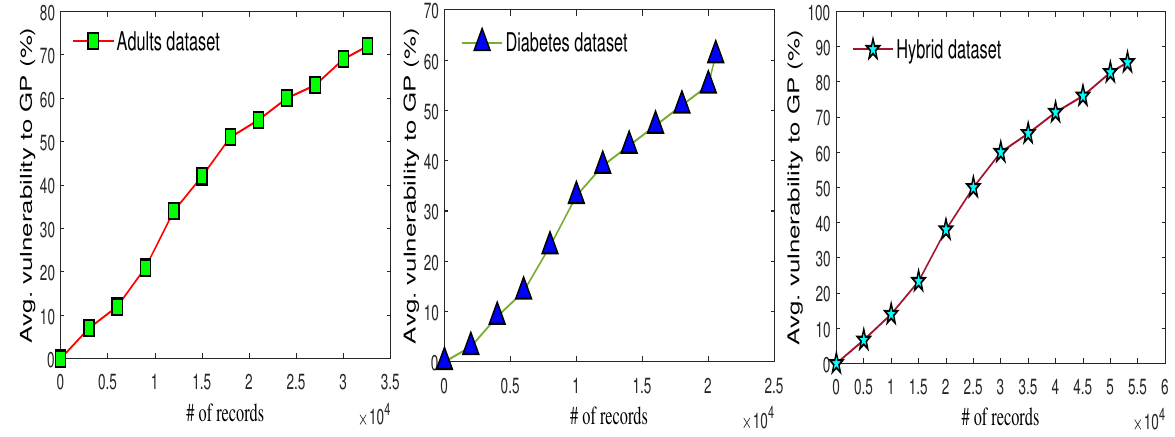
Figure 15. Experimental results for vulnerability of group privacy in real-world datasets.